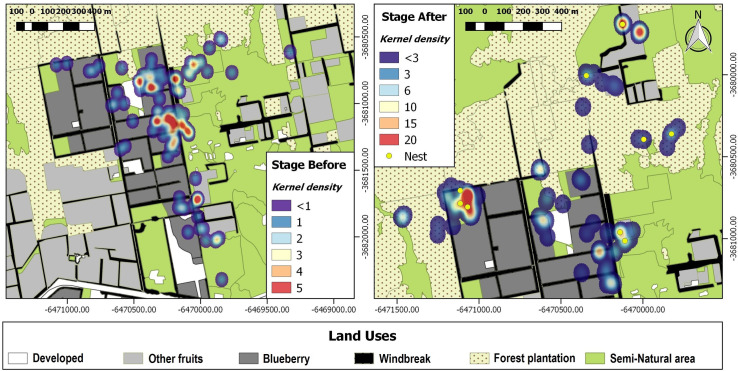
Kernel density maps of tracking bumblebees’ queens before and after setting a nest.Red values (warm colors) indicate high probability presence while cool colors (blue) tend to low probability of using the space. The maps were made from the pooled data for all the queens followed, differentiated before and after setting a nest.